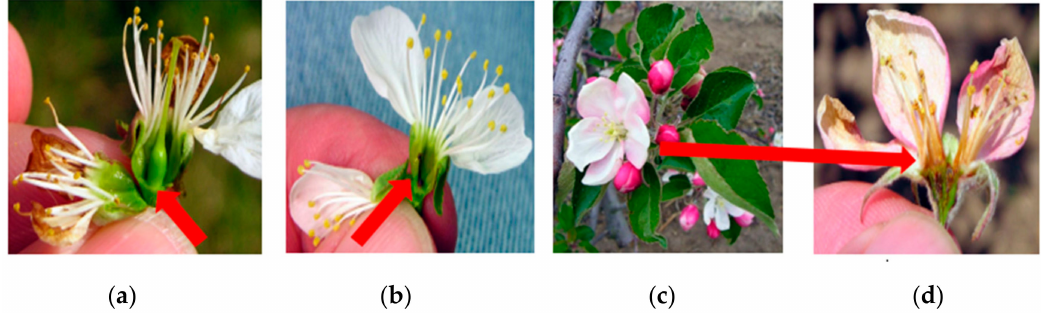
Figure 6. ( a ) This cherry flower was not damaged by a freeze the day before. ( b ) The pistil of this cherry flower was killed by a spring freeze the day before and has shriveled and turned black. ( c ) The king bloom of the apple flower cluster has opened, but the side blooms are still closed. The king bloom is more susceptible to freeze injury at all stages of the apple bud development in the spring and is often the first flower killed in the cluster. ( d ) The dark brown center of the flower indicates it was killed by a freeze